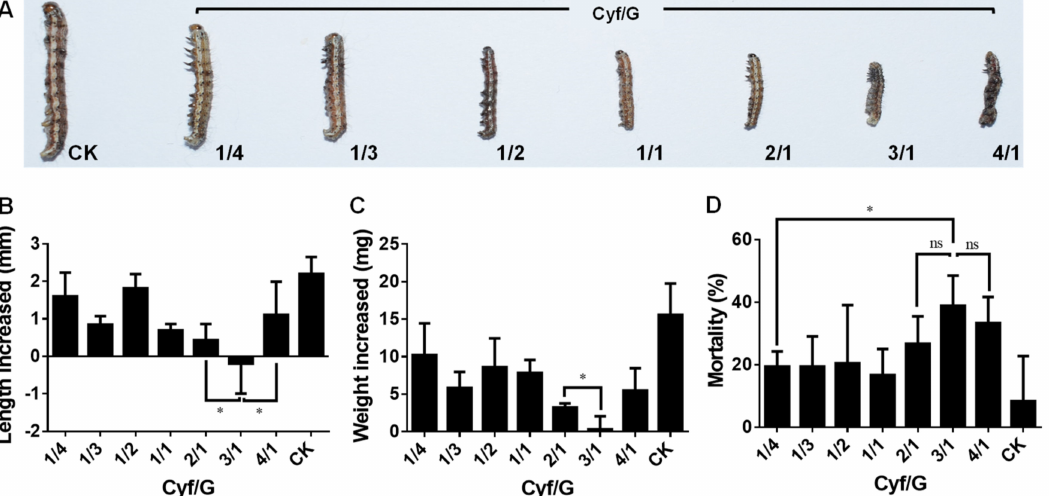
Figure 5. Insecticidal activity of Cyh/G mixtures against cotton bollworm. ( A ) Phenotypic effects. ( B ) Body length change, ( C ) weight change, and ( D ) mortality of the cotton bollworm. CK repre- sents distilled water control. The total concentration of all treatment groups was 100 µ g/mL. Each treatment was performed with four biological replications. Note: statistically significant differences ( α = 0.05 level) of values are indicated with “*”. “ns”: not